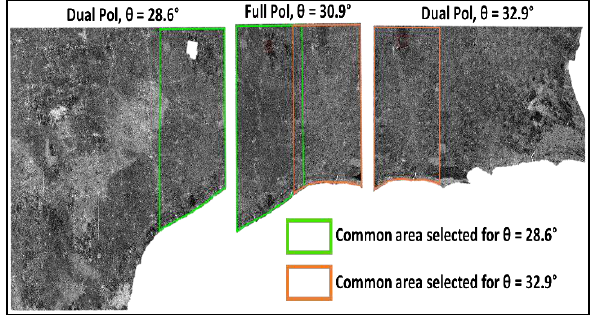
Figure 4. Extent of overlapping areas in data with different off-nadir (incidence) angle.